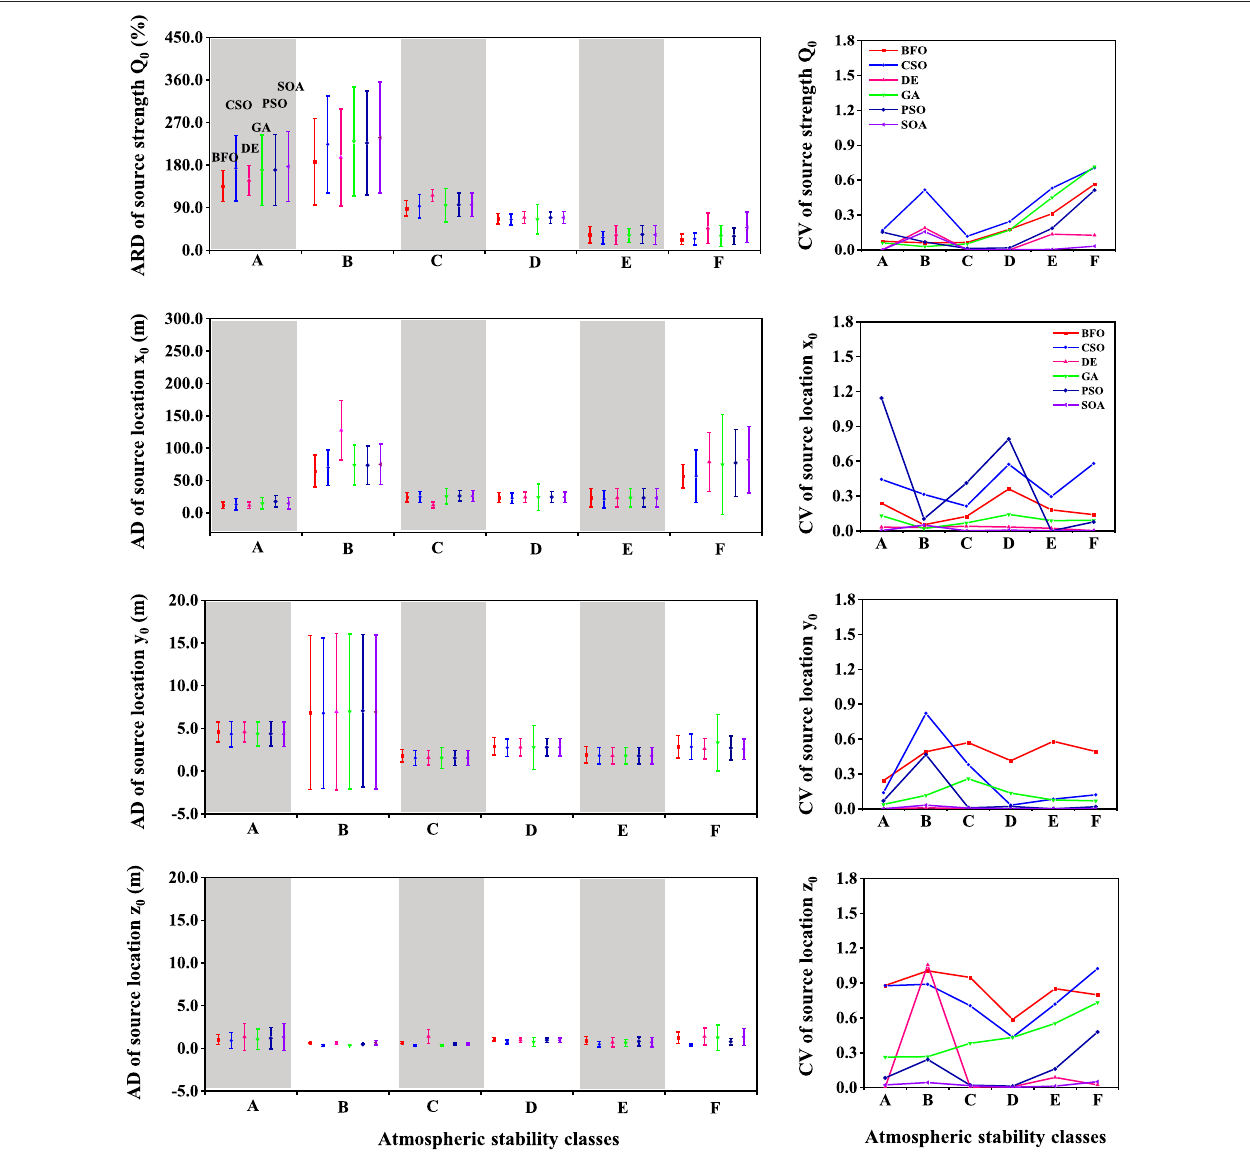
FIGURE 5 | Accuracy (mean ARD or AD with 95% con fi dence limits) and robustness (CV) of different BIOs for the estimation of source parameters (Q 0 , x 0 , y 0 , z 0 ) under different stability classes (A – F) .